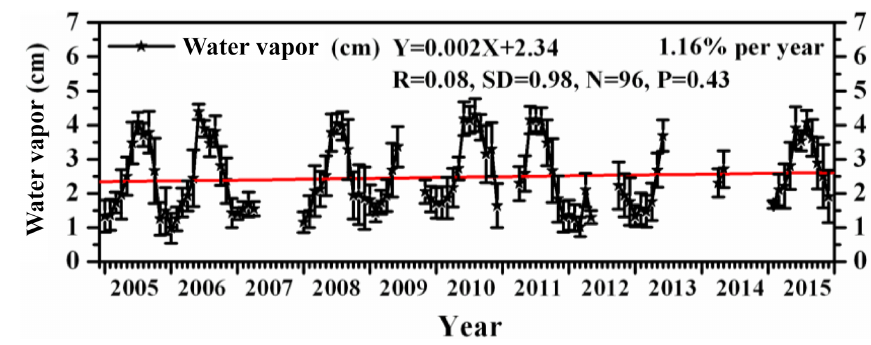
Figure 11. Monthly mean variations in columnar precipitable water content during 2005–2015 over Pune, India.